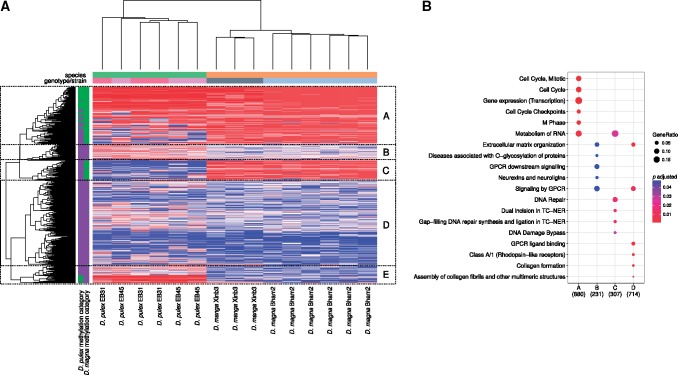
—Differences and similarities in methylation in homologous genes of D. pulex and D. magna. (A) Heatmap of ranked methylation levels (red = high, blue = low) of homologous genes in control samples, identified with reciprocal blastp (with e-value < 1e−20). Genes were ranked by the maximum methylation levels of CpGs located within unique exons, and the sub-cluster (A–E) were identified with cutree. The side panel shows the average methylation level in two categories (green >50%, purple <50%) for both species. The top panel shows the species, strain, and genotypes in different colors that correspond with the sample names at the bottom. (B) Enrichment analysis of genes within sub-clusters, using Reactome, shows the top five significantly enriched categories for each cluster (see supplementary table S8, Supplementary Material online for a comprehensive list).